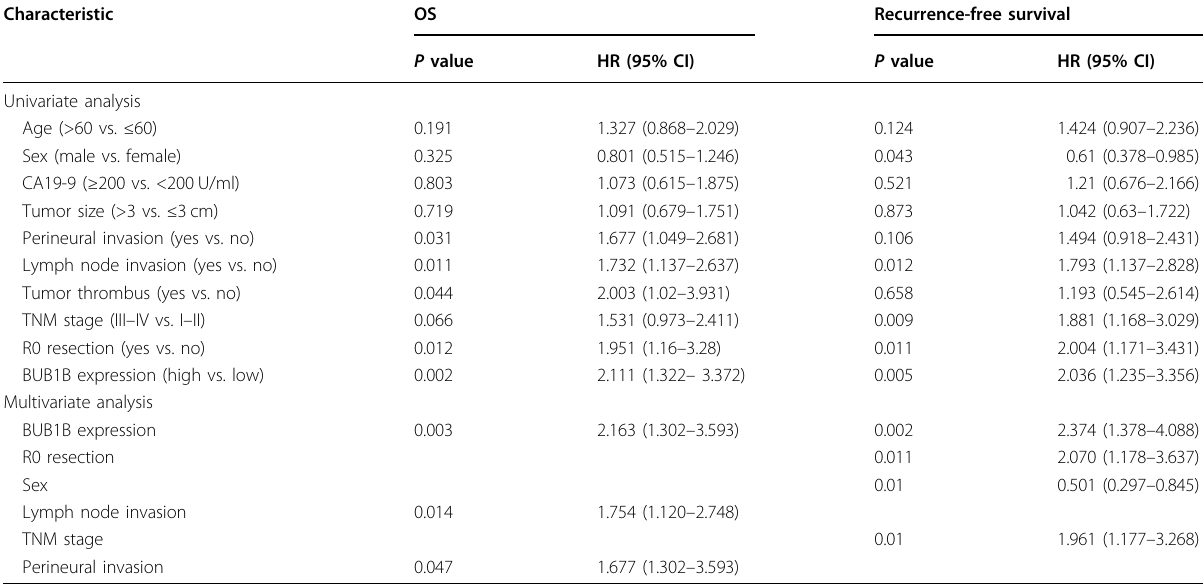
Table 1 Univariate and multivariate analyses for OS and recurrence-free survival of ECC patients. Characteristic OS Recurrence-free survival P value HR (95% CI) P value HR (95%